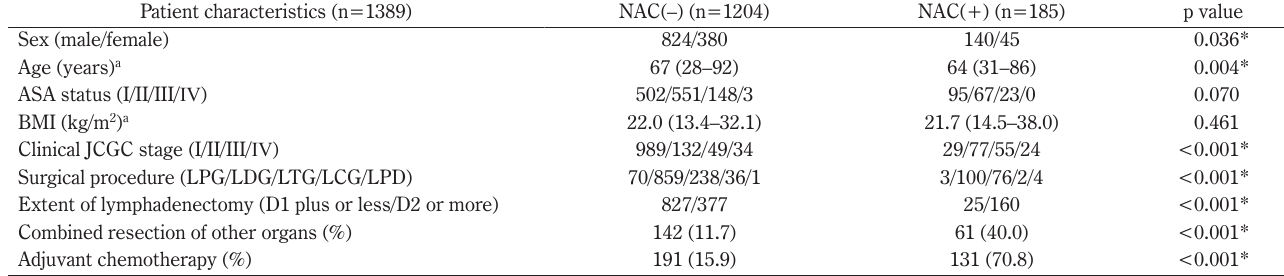
Table 1 Background and treatment-related factors of all patients who underwent laparoscopic gastrectomy with or without NAC, before propensity score matching